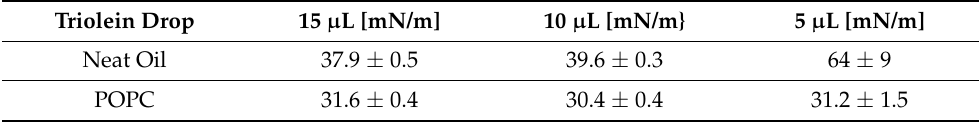
Table 1. Examples of triolein droplet surface tension values as reported by